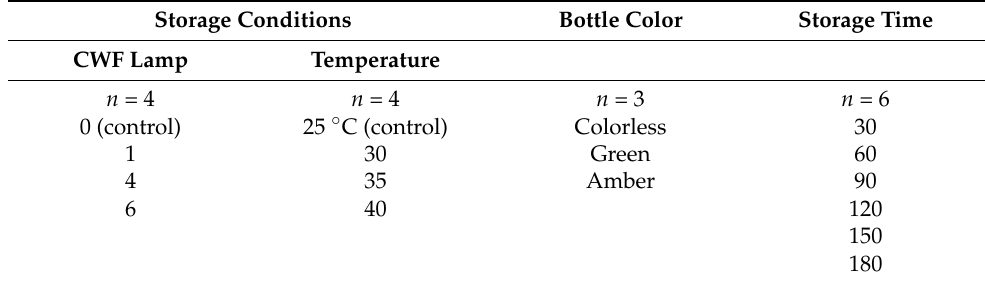
Table 1. Experimental